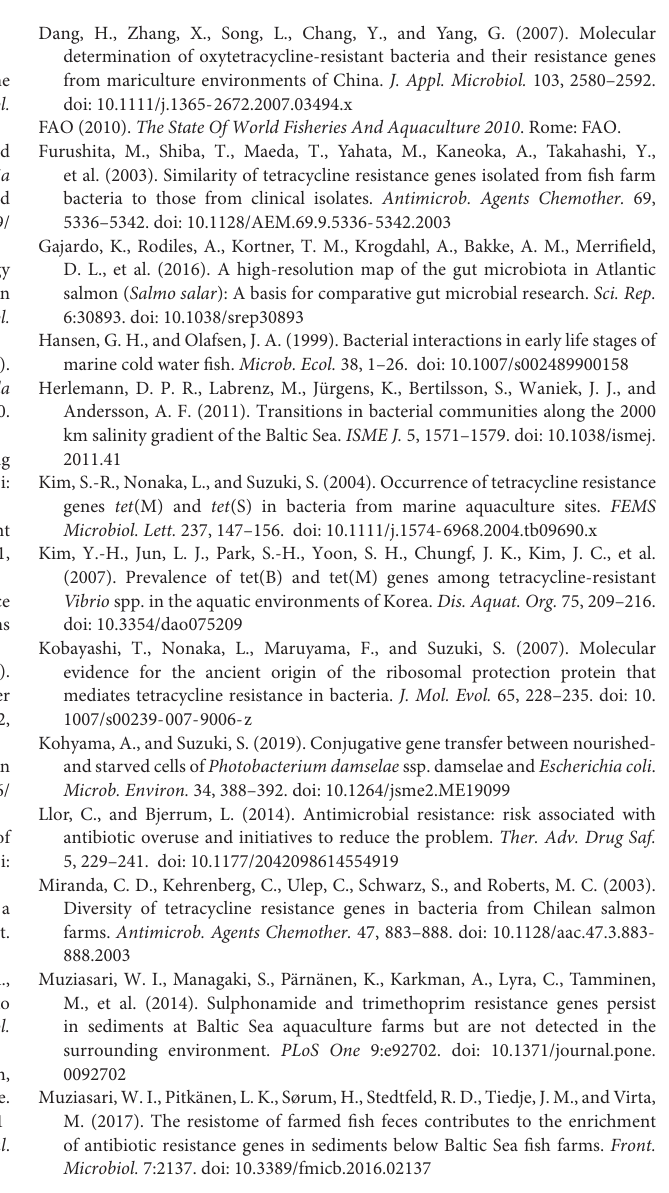
FIGURE S1 | Fish rearing system used in this study (A) , and dissection used to recover the intestinal content from the fish (B,C) . FIGURE S2 | Rarefaction curves plotting the number of OTUs. At the bottom of each panel, the sample names for each bar are coded as follows: W, water samples; G, fish gut (intestine) samples. FIGURE S3 | Copy numbers of tet genes in individual fish intestines; values were normalized to 16S rRNA gene copy number in the respective sample. Different tet genes are indicated by different bar colors. TABLE S1 | List of primers used in this study for the quantitative PCR targeting of six tet genes and the 16S rRNA genes. TABLE S2 | Average and standard deviation of tet gene abundances normalized by quantity of 16S rRNA gene ( tet copies/16S copies). n: Number of the samples in each sample